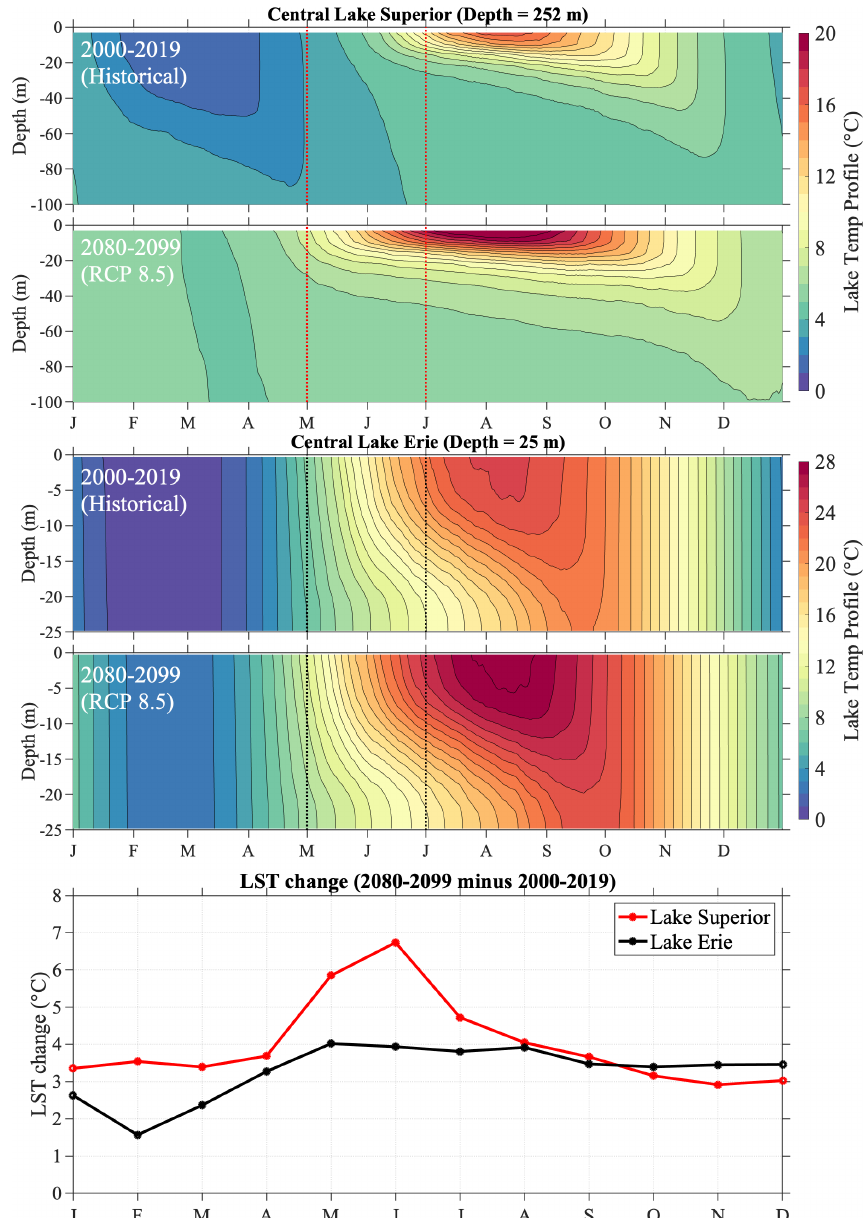
Figure 12. Lake thermal structures in central Lake Superior (two upper panels) and Lake Erie (two middle panels) in the present-day climate (2000–2019) and late century (2080–2099). (bottom panel) Comparison of projected changes in monthly LST for Lake Superior and